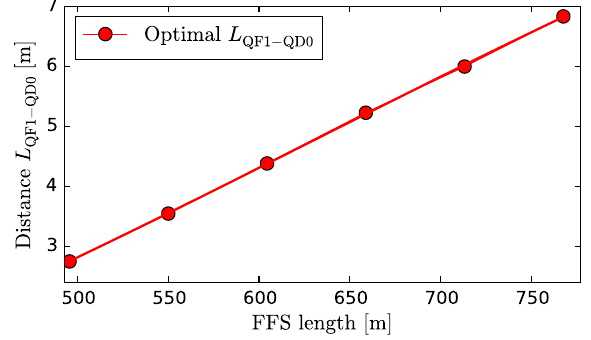
for σ (cid:1) x; 2 minimization QF 1 -QD 0 ndorder